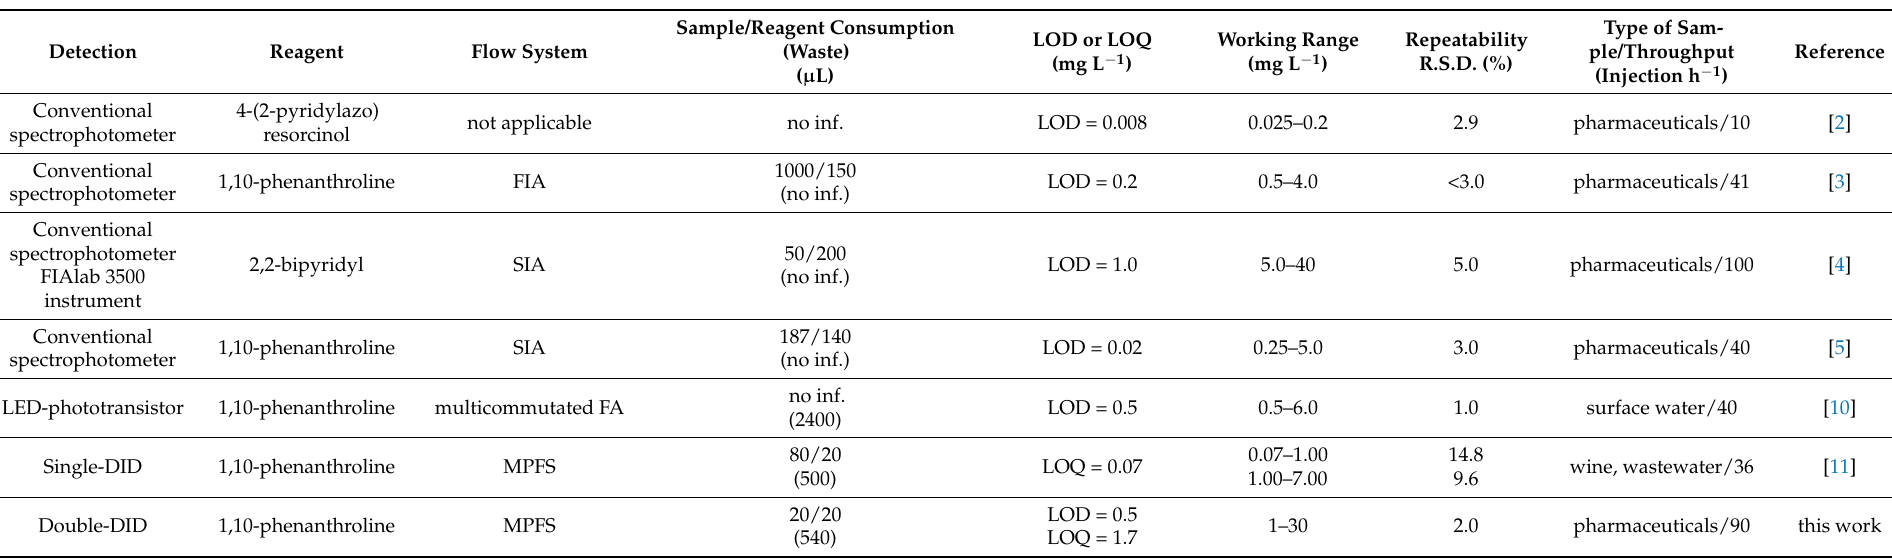
Table 3. Comparison of spectrophotometric methods of iron(II) determination. LOD, limit of detection; LOQ, limit of quantification; R.S.D., relative standard